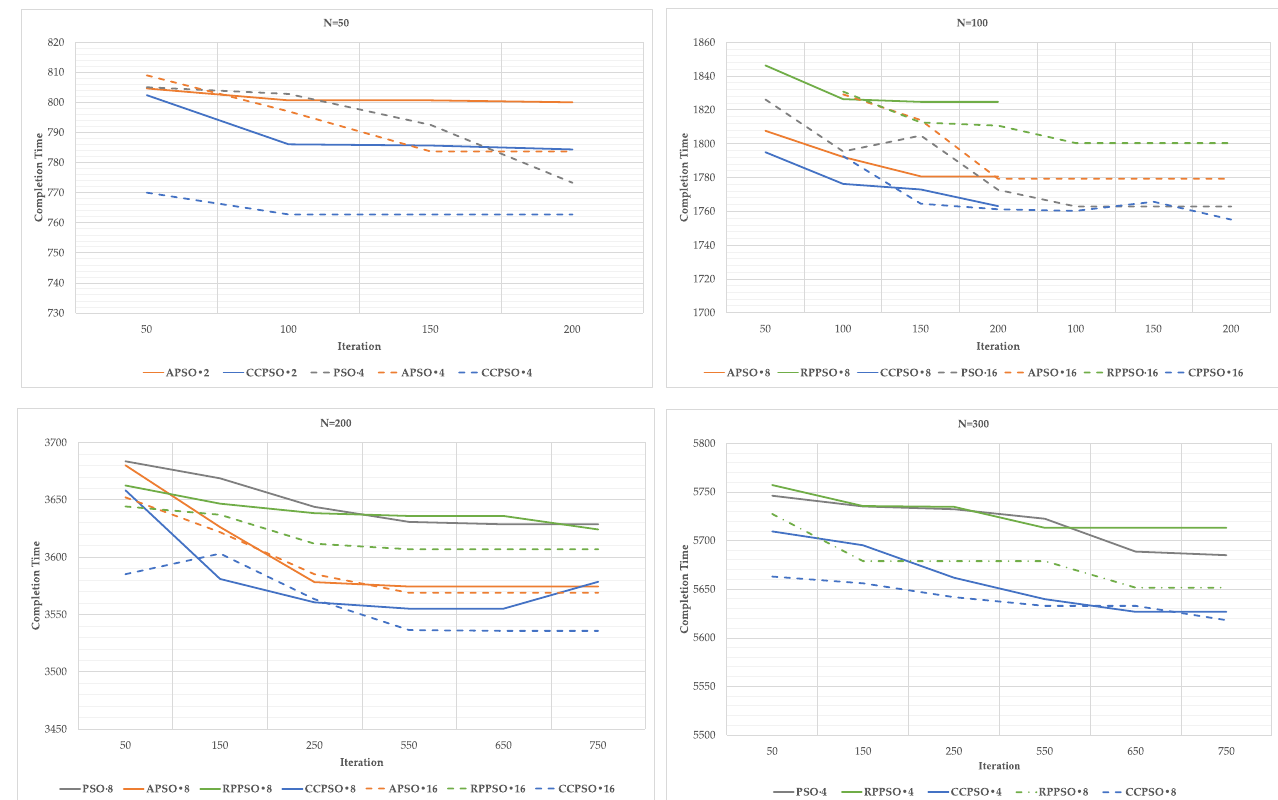
Figure 11. Comparison chart for PSO, APSO, RPPSO and CCPSO.